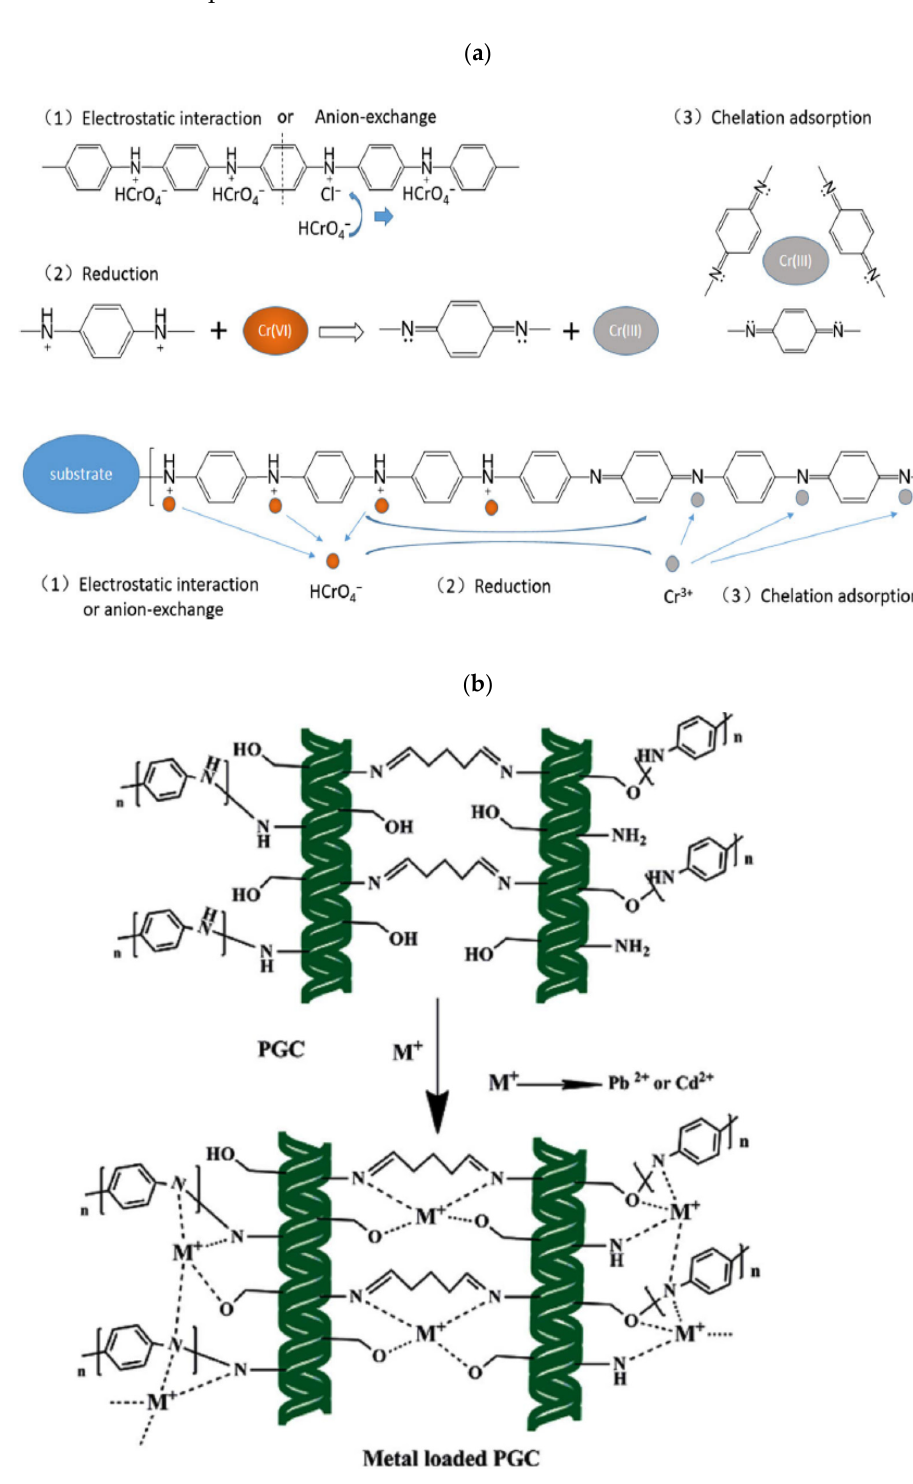
Figure 2. ( a ) Mechanism of chromium removal by PANI and PANI-based composites. Reprinted with permission from Ref. [30]. Copyright 2018 Springer Nature. ( b ) Proposed mechanism for the adsorption of Pb and Cd onto PANIGCS. Reprinted with permission from Ref. [25]. Copyright 2015